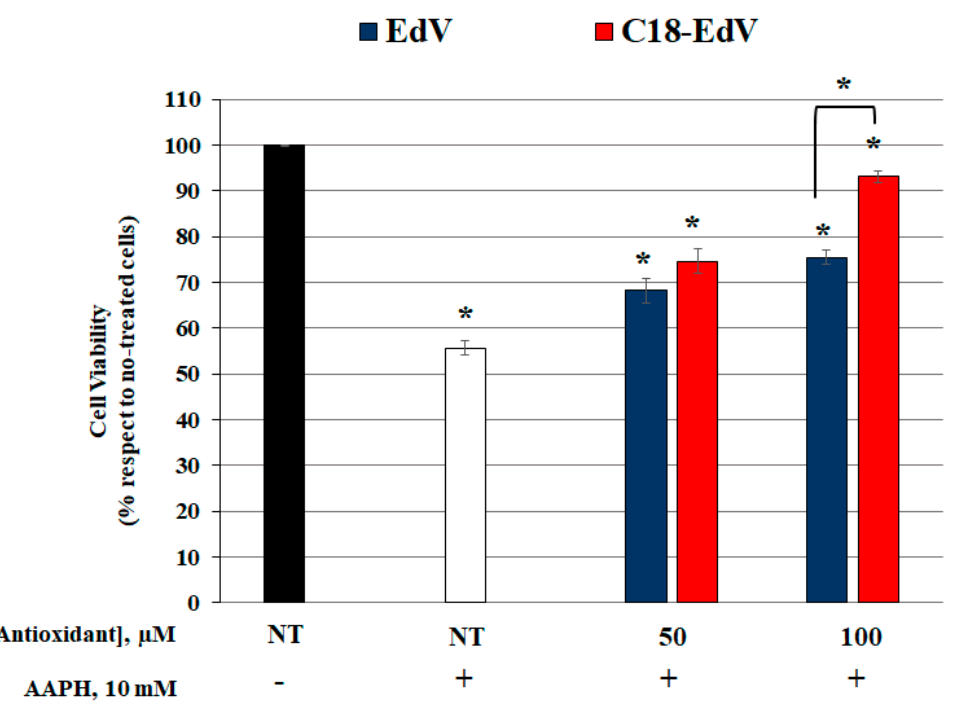
Figure 5. Effect of C18-Edravone in ARPE19 cells after AAPH exposure. The cells were pre-treated with 50 and 100 µM concentrations of C18-edaravone and edaravone for 24 h, before being exposed to 10 mm AAPH for 24 h. Cell viability was determined by MTT assay. Data are expressed as means ± S.D. of five independent experiments, each performed in triplicate. Differences between AAPH-treated cells vs. no-treated cells or EdV and C18-EdV treatments and between EdV vs. C18-EdV at 100 µM concentration were assessed using Tukey’s post hoc test, * p < 0.0001.